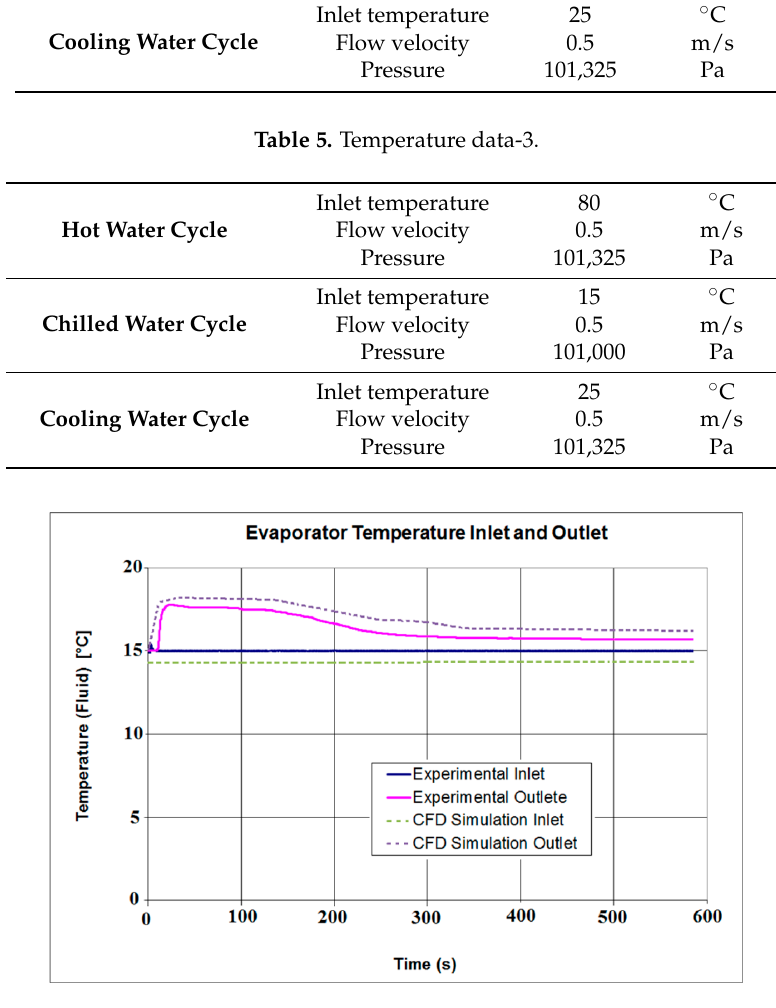
Figure 8. The refrigerant temperature in the evaporator by J. White ©2012 [10].